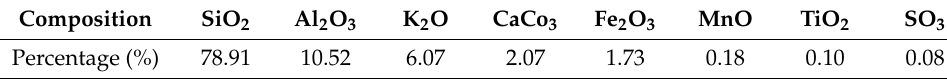
Figure 1. SEM image of granite dust. Table 1. Chemical composition of granite dust obtained via XRF